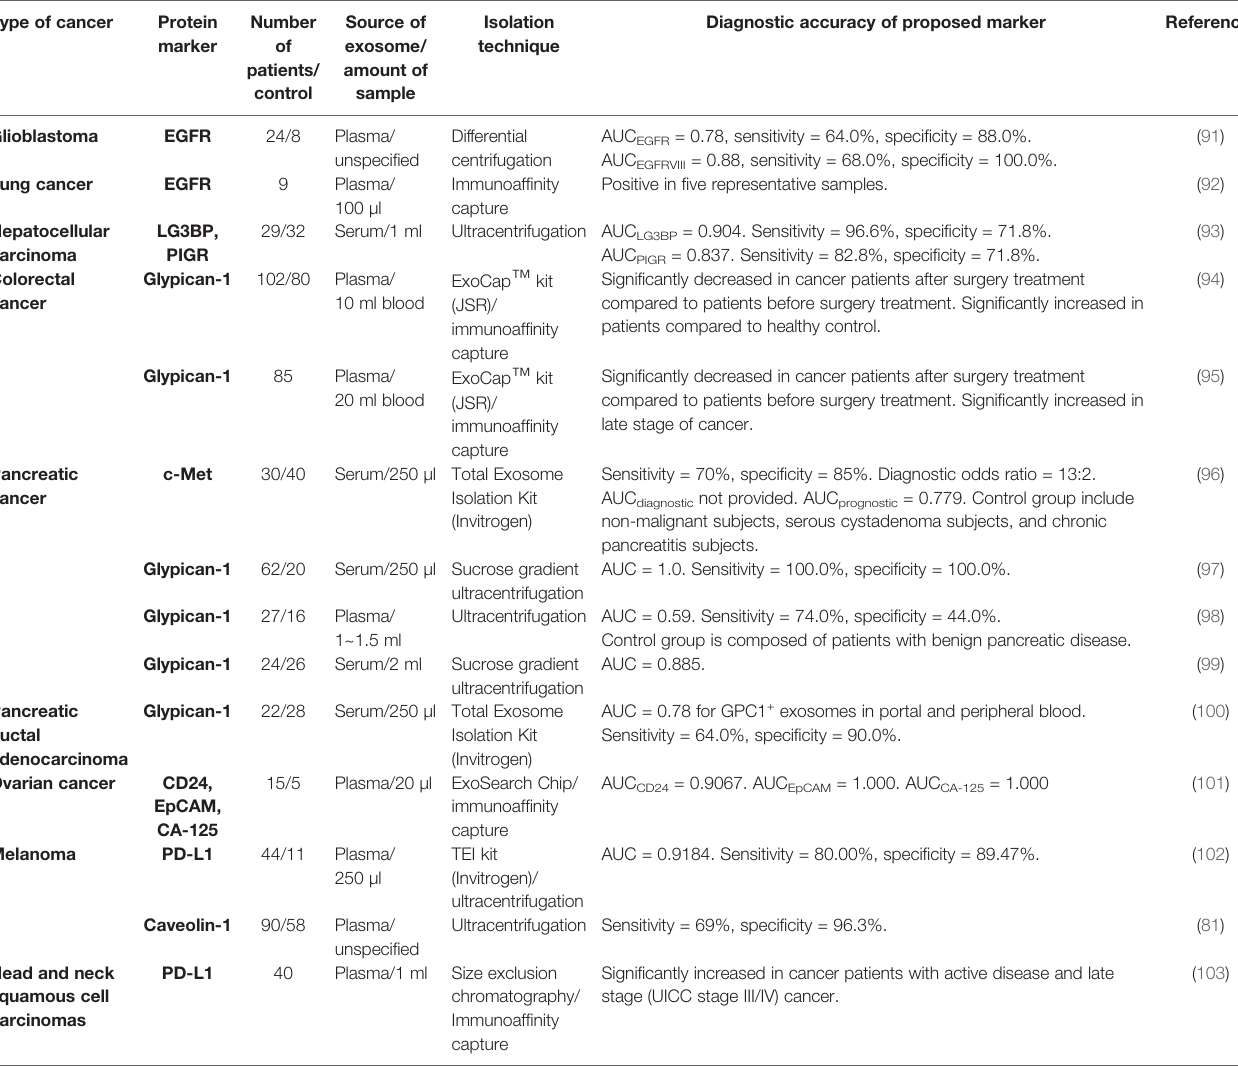
TABLE 5 | Tumor-associated exosomal